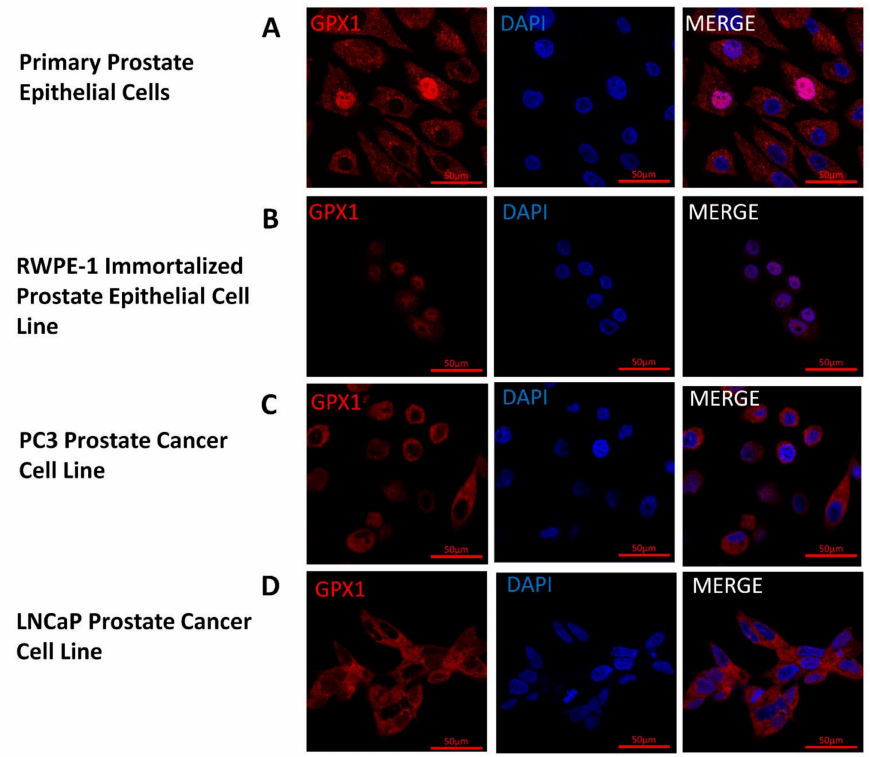
Figure 3. Location and levels of GPX1 in cultured cells. GPX1 appears in red and nuclei are indicated by staining with 4’,6-diamidino-2-phenylindole (DAPI) in blue. ( A ) Primary Prostate Epithelial Cell; ( B ) RWPE-1 Immortalized Prostate Epithelial Cell Line; ( C ) PC3 Prostate Cancer Cell Line; ( D ) LNCaP Prostate Cancer Cell